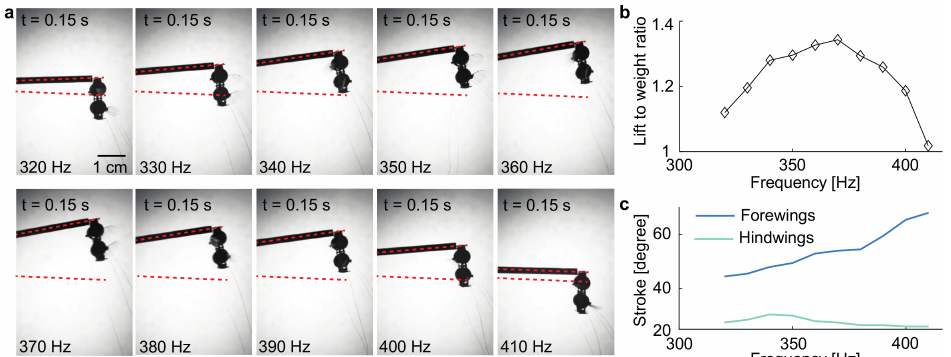
Figure 7. Effect of driving frequency f on lift force production. ( a ) Final robot liftoff positions at frequencies ranging from 320 Hz to 410 Hz. ( b ) Robot lift-to-weight ratio as a function of driving frequency. ( c ) Forewing and hindwing stroke amplitudes as a function of driving frequency.